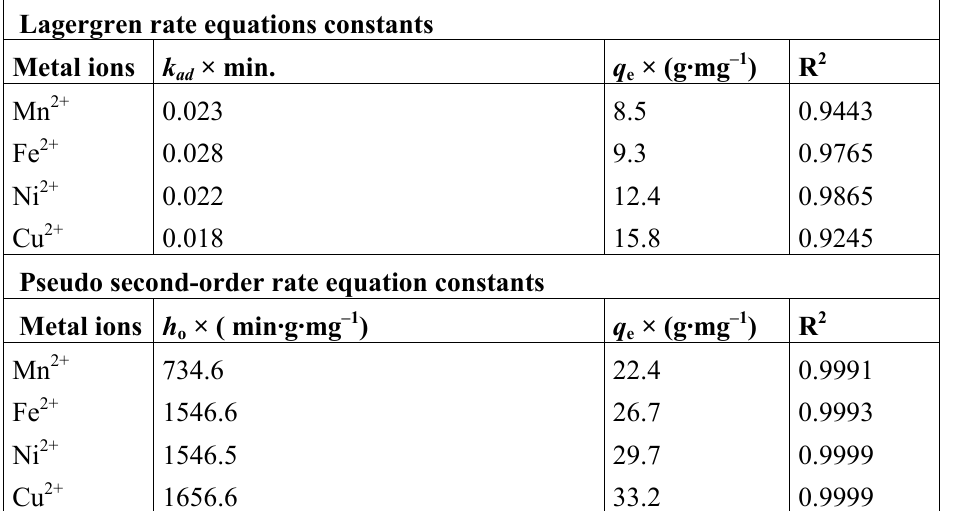
Table 2. Lagergren rate equation constants and pseudo second-order rate